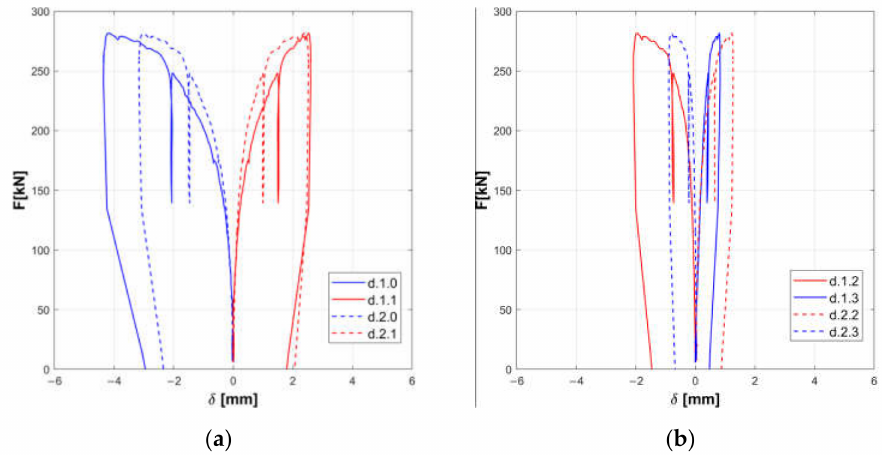
Figure 9. Experimental diagonal displacements of panel A: upper part ( a ) and lower part ( b ).